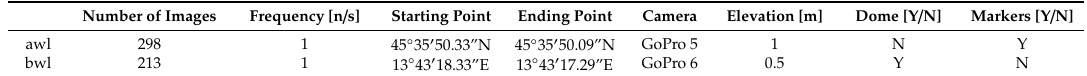
Table 2. Acquisition parameters of the seawall at Lazzaretto (Italy).